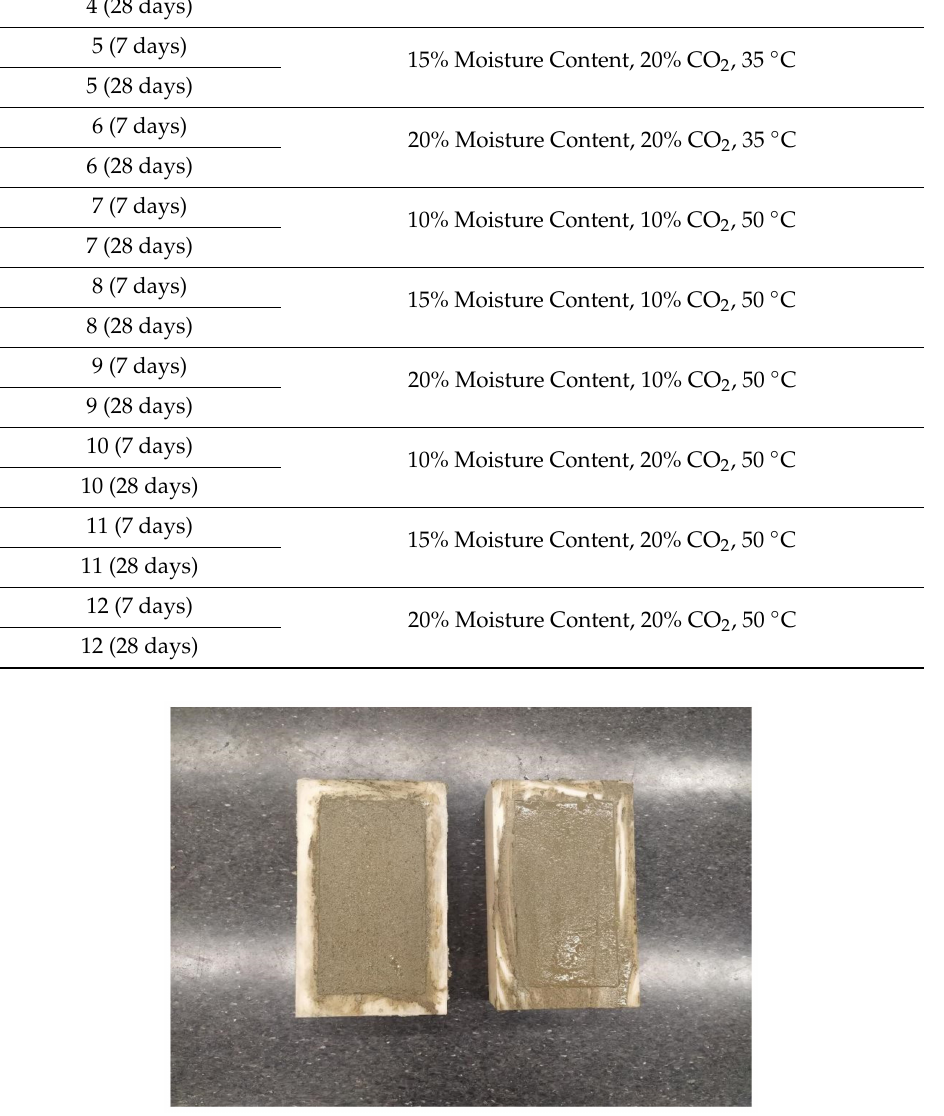
Figure 2. Compacted mix in the brick